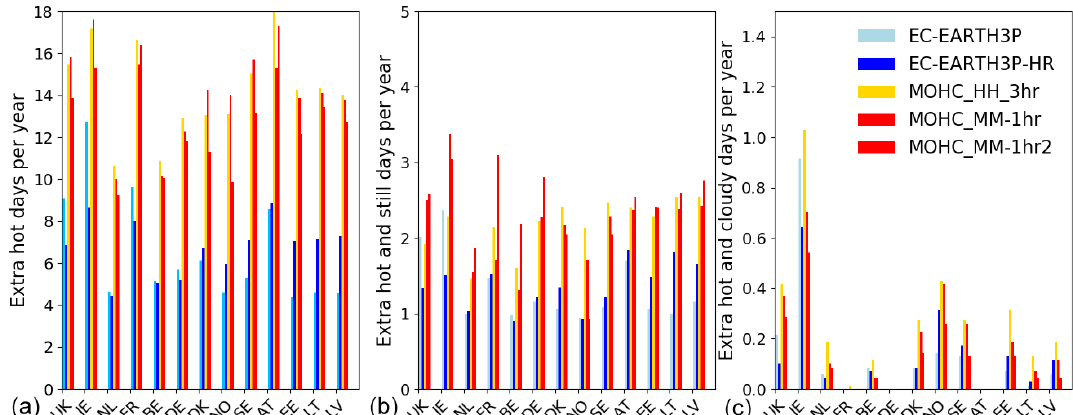
Figure 9. (a) The number of extra days per summer (June–August) in a possible future climate where daily population-weighted 2m temperature exceeds the 90th percentile value. (b) Number of days where 2m temperature exceeds 90th percentile, and 10m wind speed is below the 10th percentile. (c) Number of days where 2m temperature exceeds 90th percentile, and surface solar irradiance is below the 10th percentile. See Table 1 for further details of the